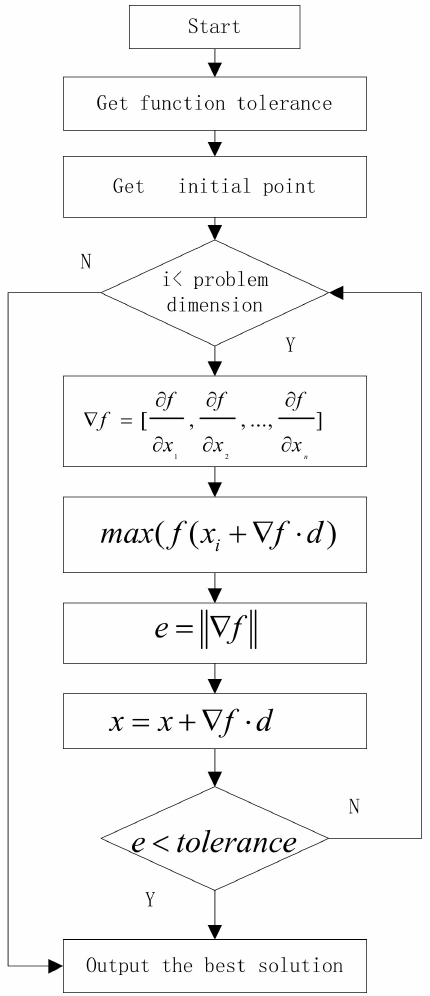
Figure 6. The flow chart for gradient descent method in seeking